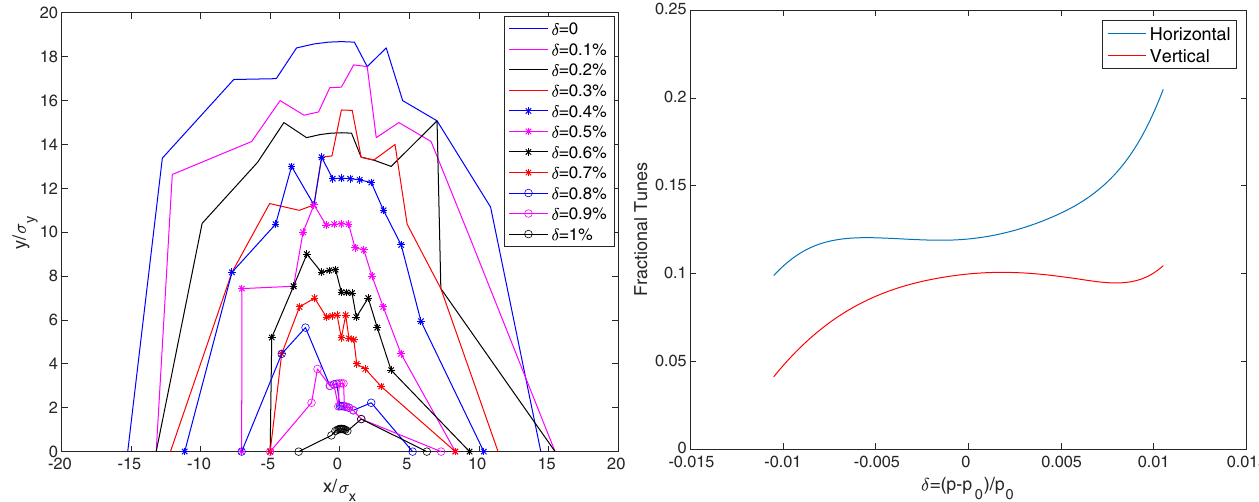
FIG. 13. Dynamic aperture (left) and chromatic tune (right) in the lattice optimized with the hybrid chromatic compensation